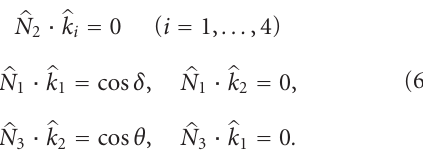
contribution to the bispectrum of ζ , properly normalized in the